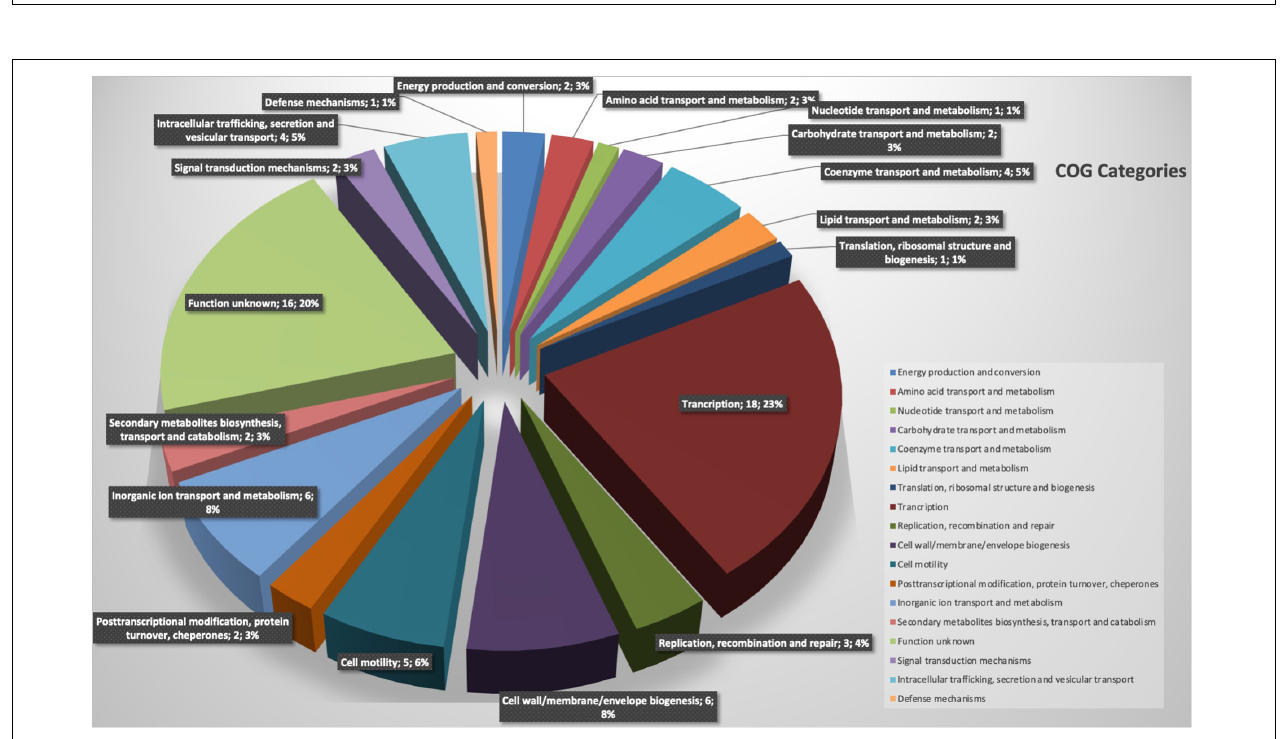
FIGURE 3 | Representation of functional categories of novel regions of strain BBB001 T .